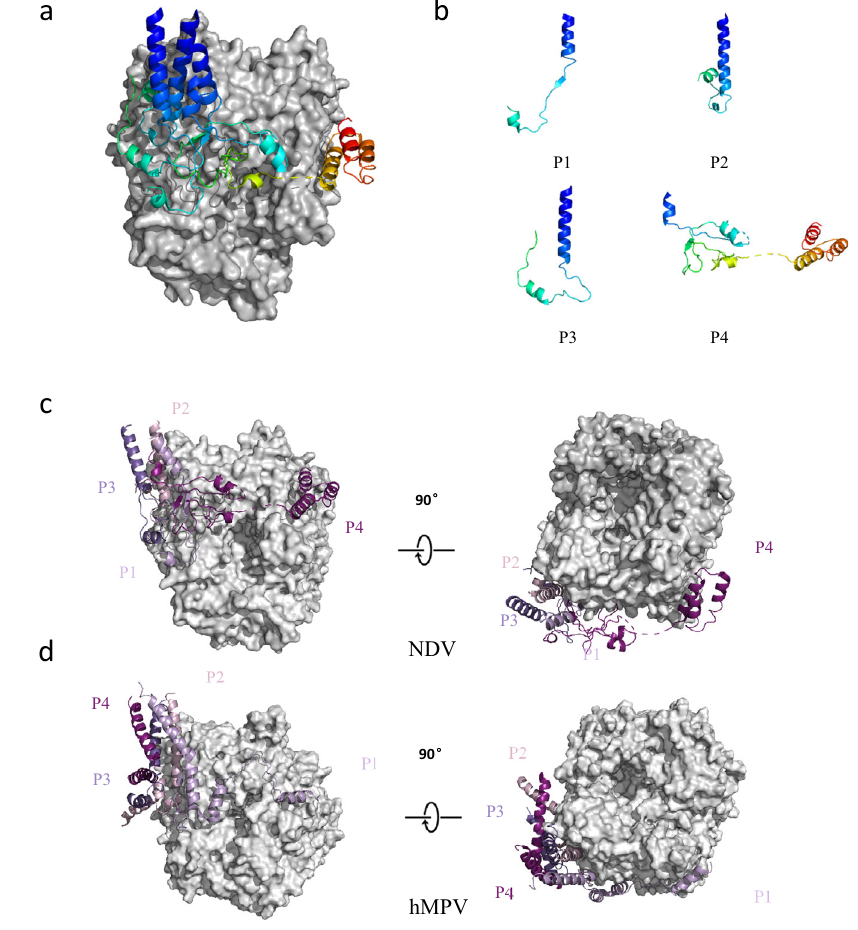
Fig. 4 | Phosphoprotein tetramer in complex with L. a NDV L is shown as a gray molecular surface, and P monomers are shown in cartoon. The P monomer is colored as a blue-to-red rainbowfrom theN- to the C-terminalend. b Structures of